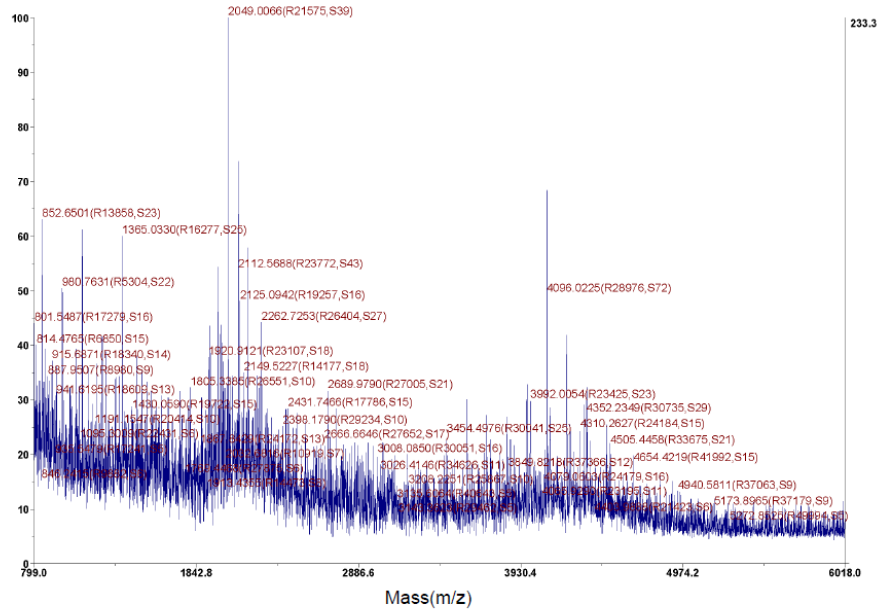
Figure 5. MALDI-TOF MS spectrum of the purified active product from Streptomyces STZ.